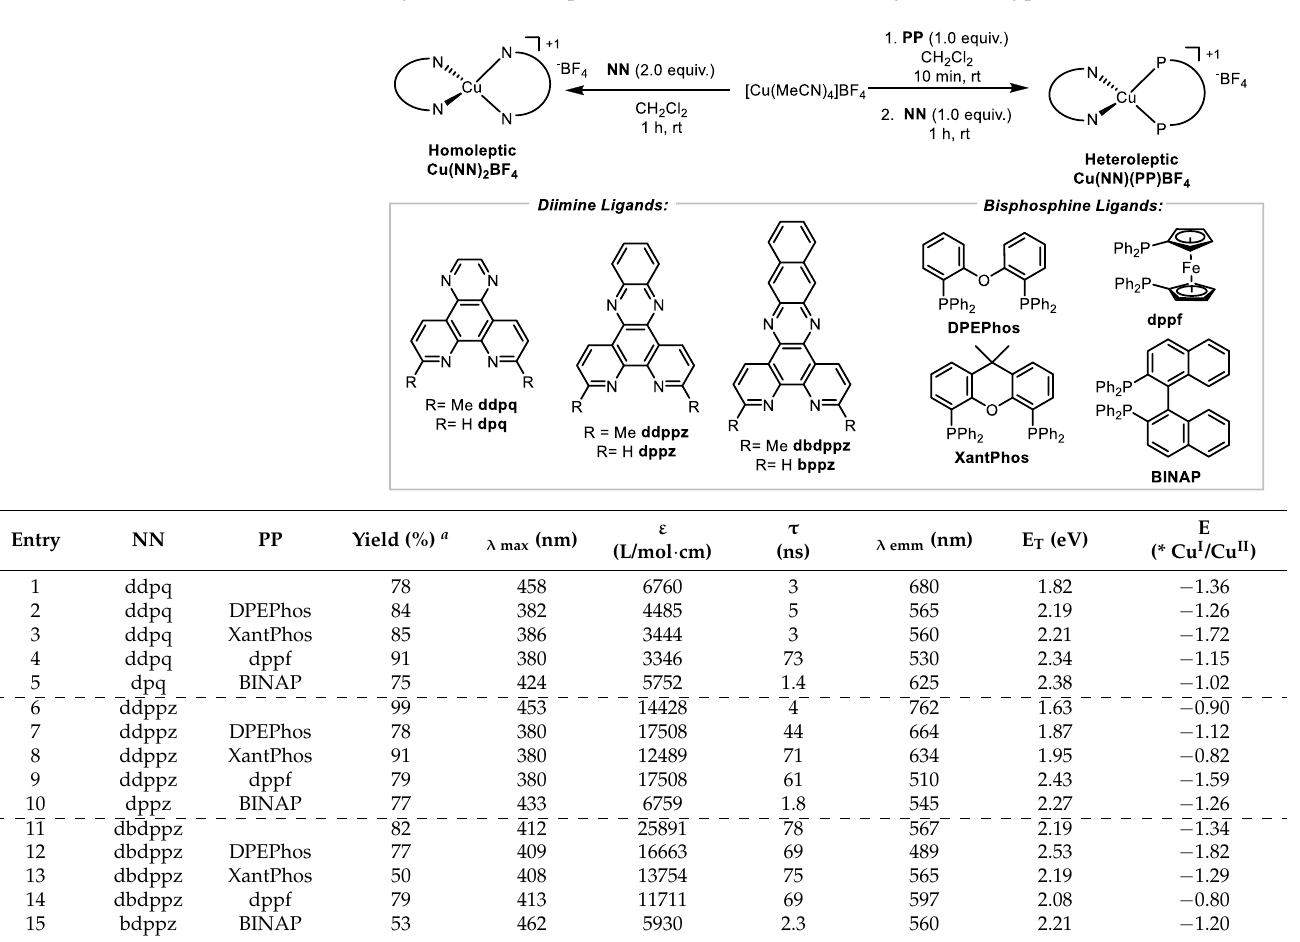
Table 1. Synthesis and Properties of Cu(I)-Based Photocatalysts of the Type Cu( NN )( BINAP )BF 4 .